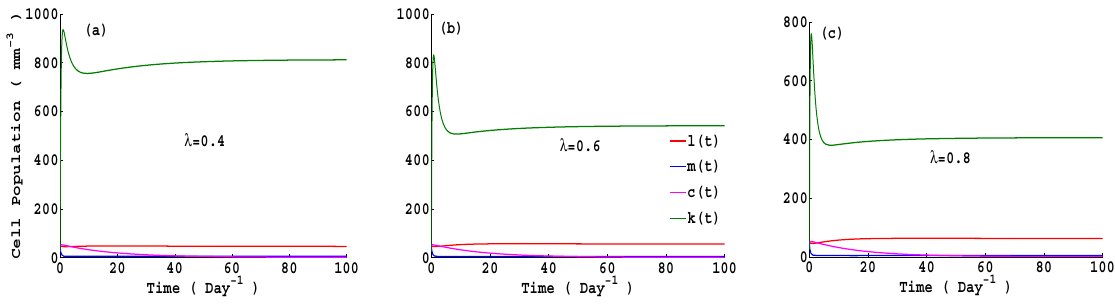
Fig. 1. Behaviors of different cell biological masses of the system (1) with u 1 = 0 . 5 and u 2 = 0 . 7 for λ = 0 . 4 (Panel a), λ = 0 . 6 (Panel b) and λ = 0 . 8 (Panel c), keeping other parameters at their standard values as in Table